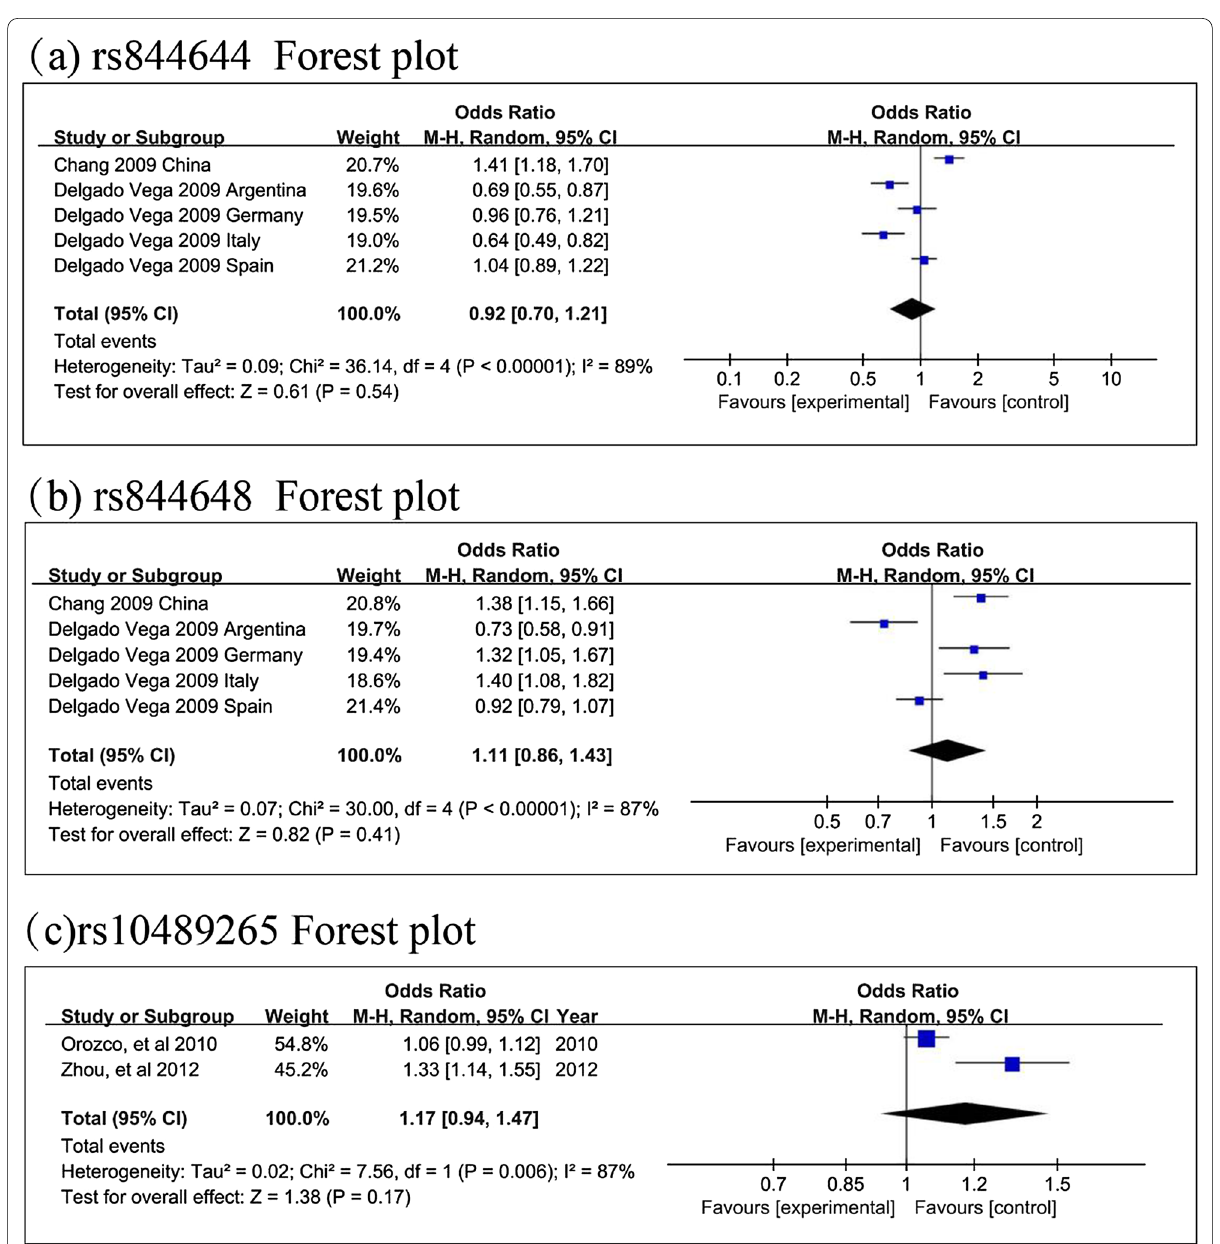
Fig.3 Forest plot for the meta‑analysis of the association between TNFSF4 rs844644 polymorphism (Cvs.A) ( a ), TNFSF4 rs844648 polymorphism (Avs.G) ( b ), rs10489265 polymorphism ( c ) and